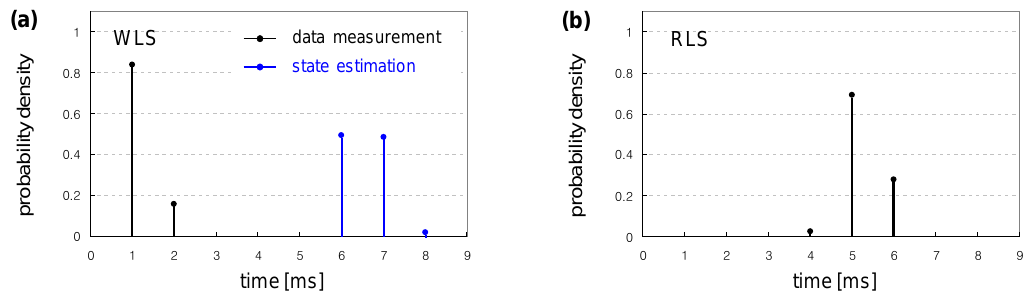
Figure 4. Comparison of ( a ) WLS and ( b ) RLS in terms of execution time